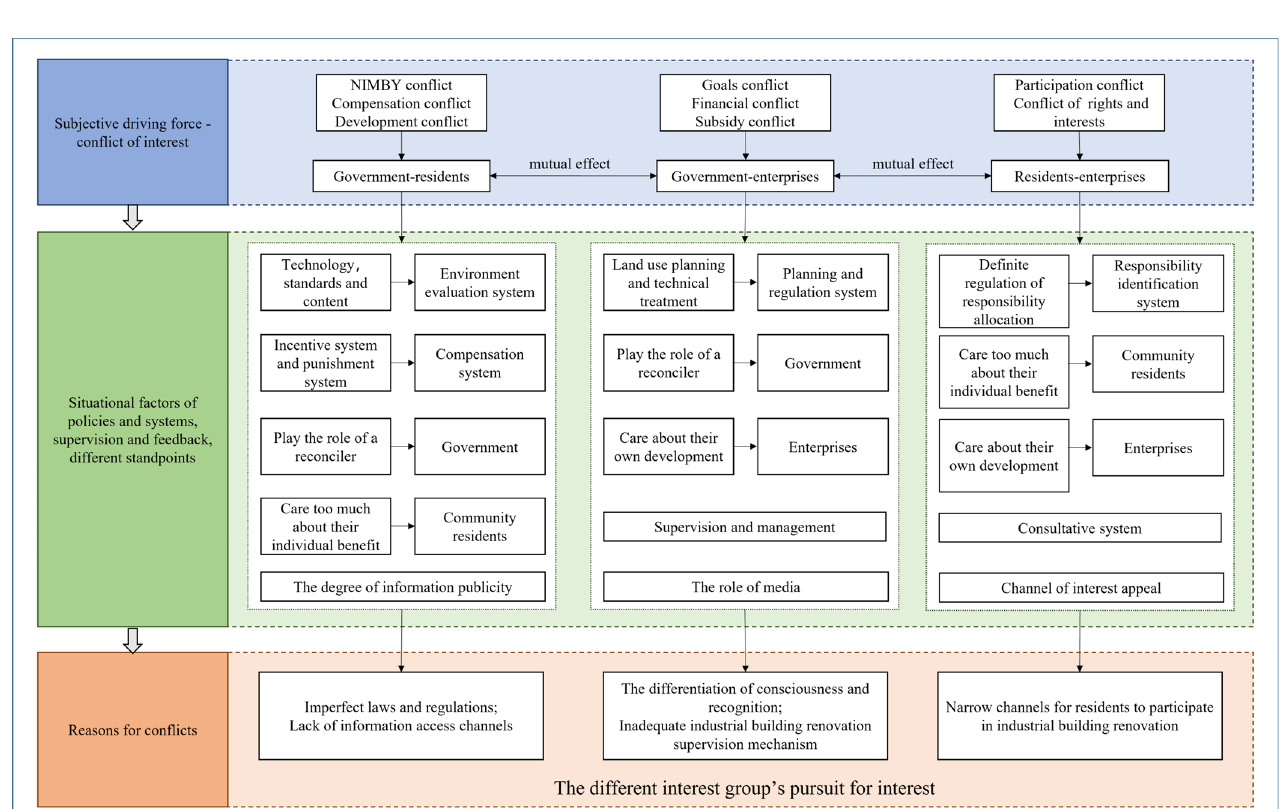
Figure 3. The interest–situation–conflict model.